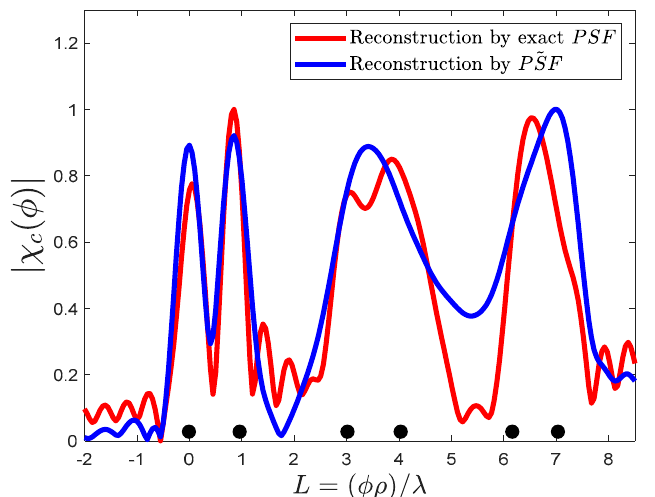
Figure 16. The reconstructions of some point-like scatterer by both actual and approximated PSFs. The black dots indicate the position of the scatterer points.